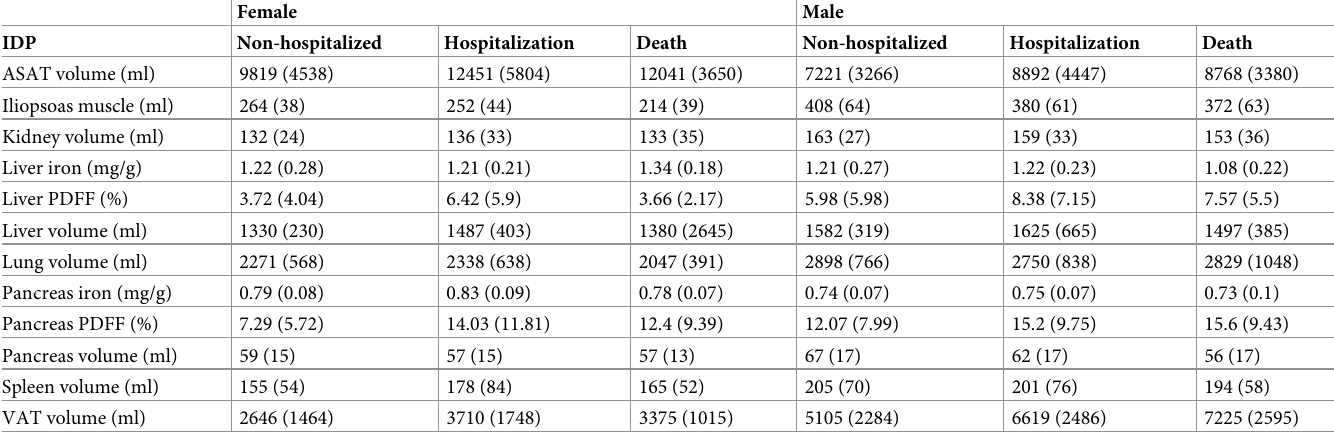
Table 4. Baseline image-derived phenotypes in COVID-19 cases, stratified by disease severity, including separately death, hospitalization, and non-severe outcomes. Female Male